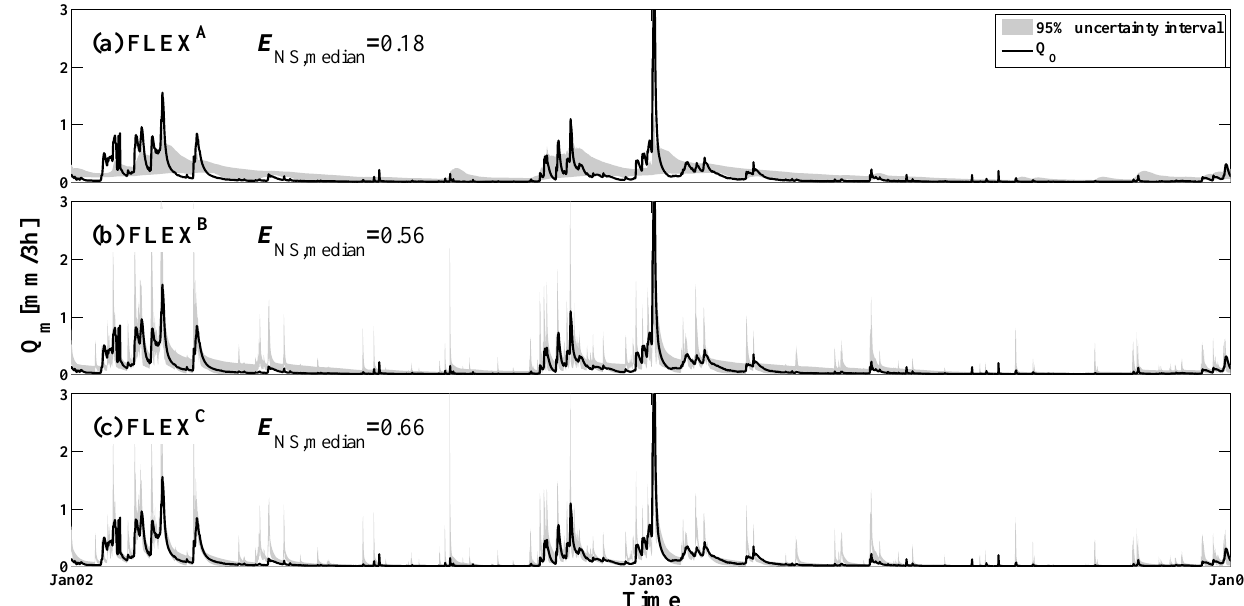
Figure 1. The observed hydrograph and the 95% uncertainty interval of the modeled hydrograph derived from the complete set of constrained but un-calibrated parameter sets for the three different model set-ups (a) FLEX A , (b) FLEX B and (c) FLEX C for the 2 years (2002–2003) of calibration period. The median performance of the constrained but un-calibrated models based on Nash–Sutcliffe efficiency ( E NS,median ) are reported (Gharari et al.,